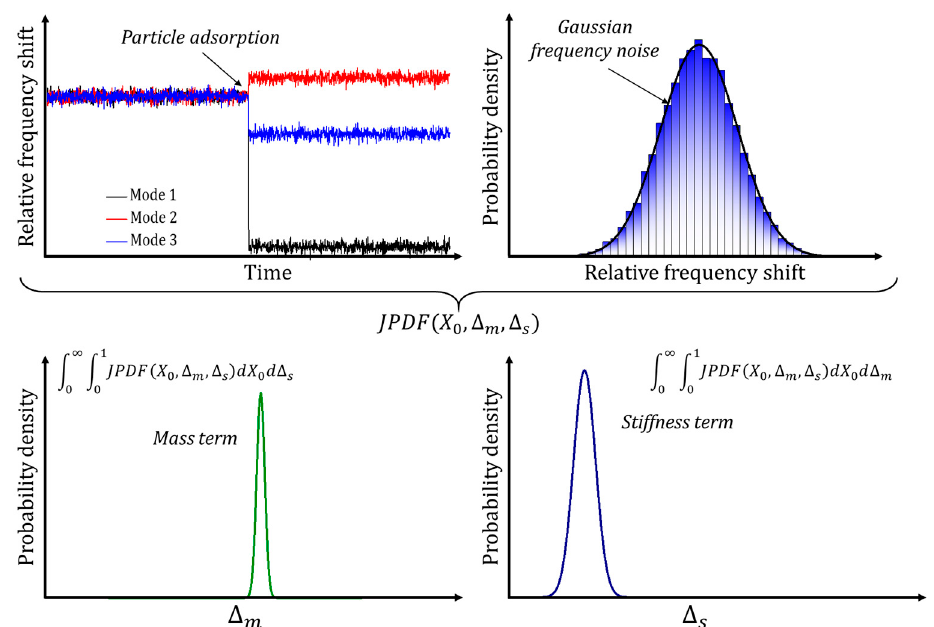
Figure 6. Schematic of the particle’s mass and stiffness determination using multimode measuring. In a first step, the frequencies of the resonator are tracked and the relative frequency shifts produced by the particle adsorption are recorded. In a second step, the joint probability density function ( JPDF ) is formed using the frequency noise for each of the modes being tracked. Finally, the JPDF can be integrated in the normalized position X 0 and either in ∆ s or ∆ m to obtain the mass or the stiffness 𝑃𝐷𝐹 , respectively.